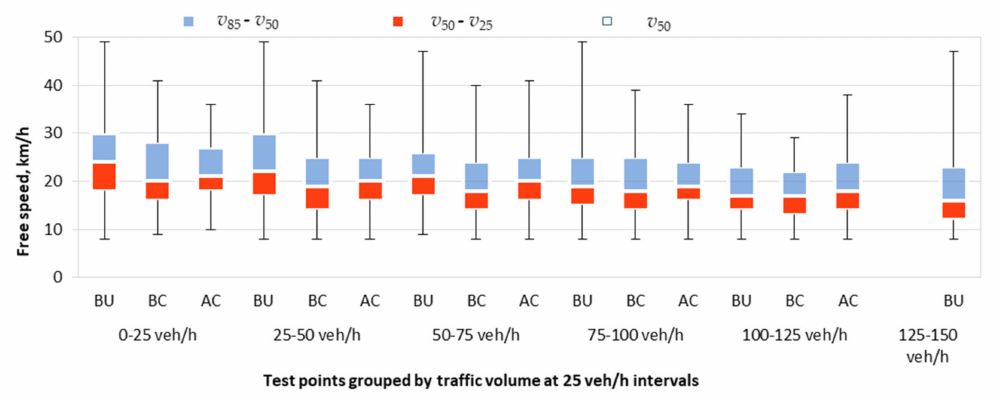
Figure 9. Summary of speed range analysis before and after upgrading, on the approach to and after the choker—data obtained in testing ground No. 2 (BU—before upgrading, BC—before choker, AC—after choker). Source: own work of the author.